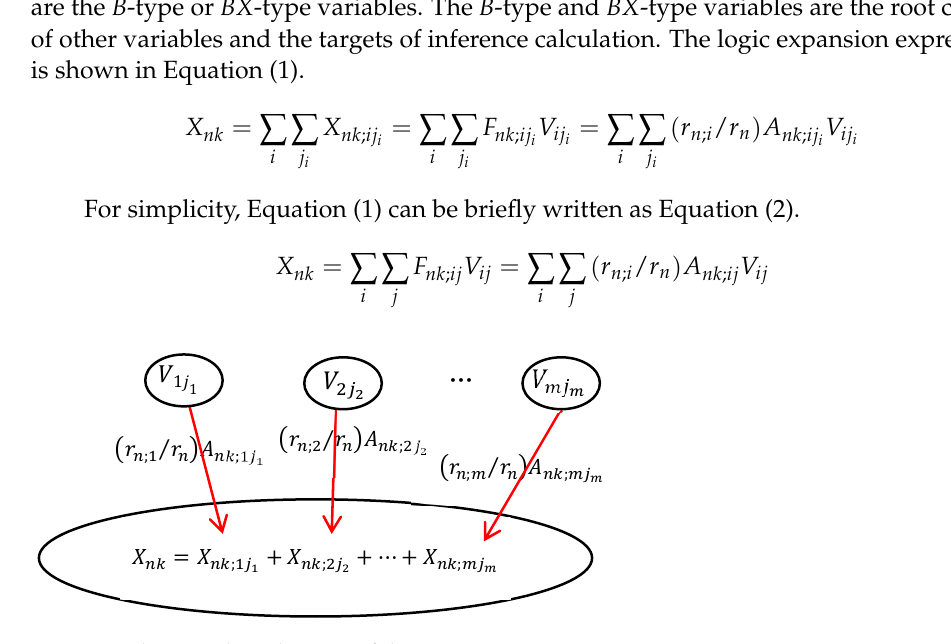
Figure 2. The causal mechanism of the DUCG.